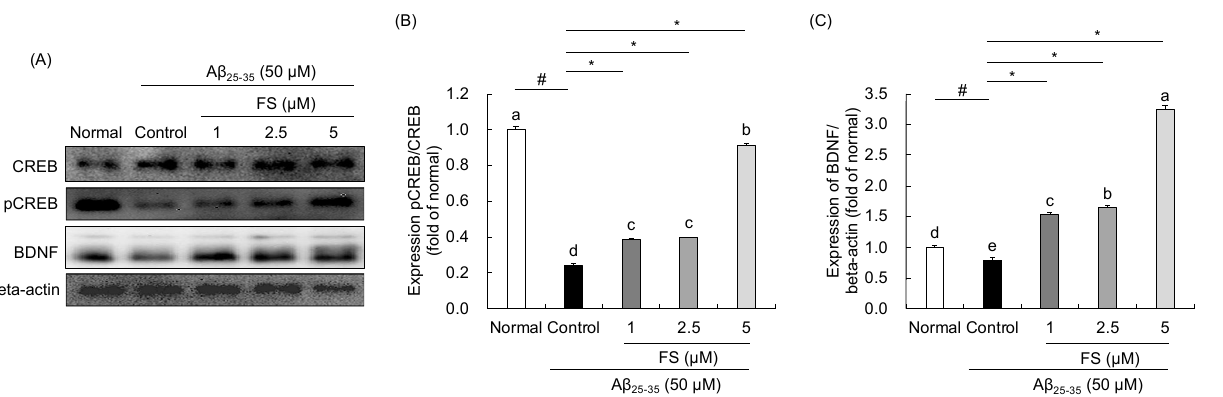
Figure 7. Effects of N -feruloyl serotonin on the regulation of CREB-BDNF signaling in SH-SY5Y cells. The western blot bands ( A ), relative protein levels of pCREB/CREB ( B ) and BDNF ( C ). Values present means ± SD ( n = 3). a–e Means with different letters are significantly different ( p < 0.05) by Duncan’s multiple range test. # p < 0.01 vs. normal; * p < 0.05 vs. control. FS, N -feruloyl serotonin.